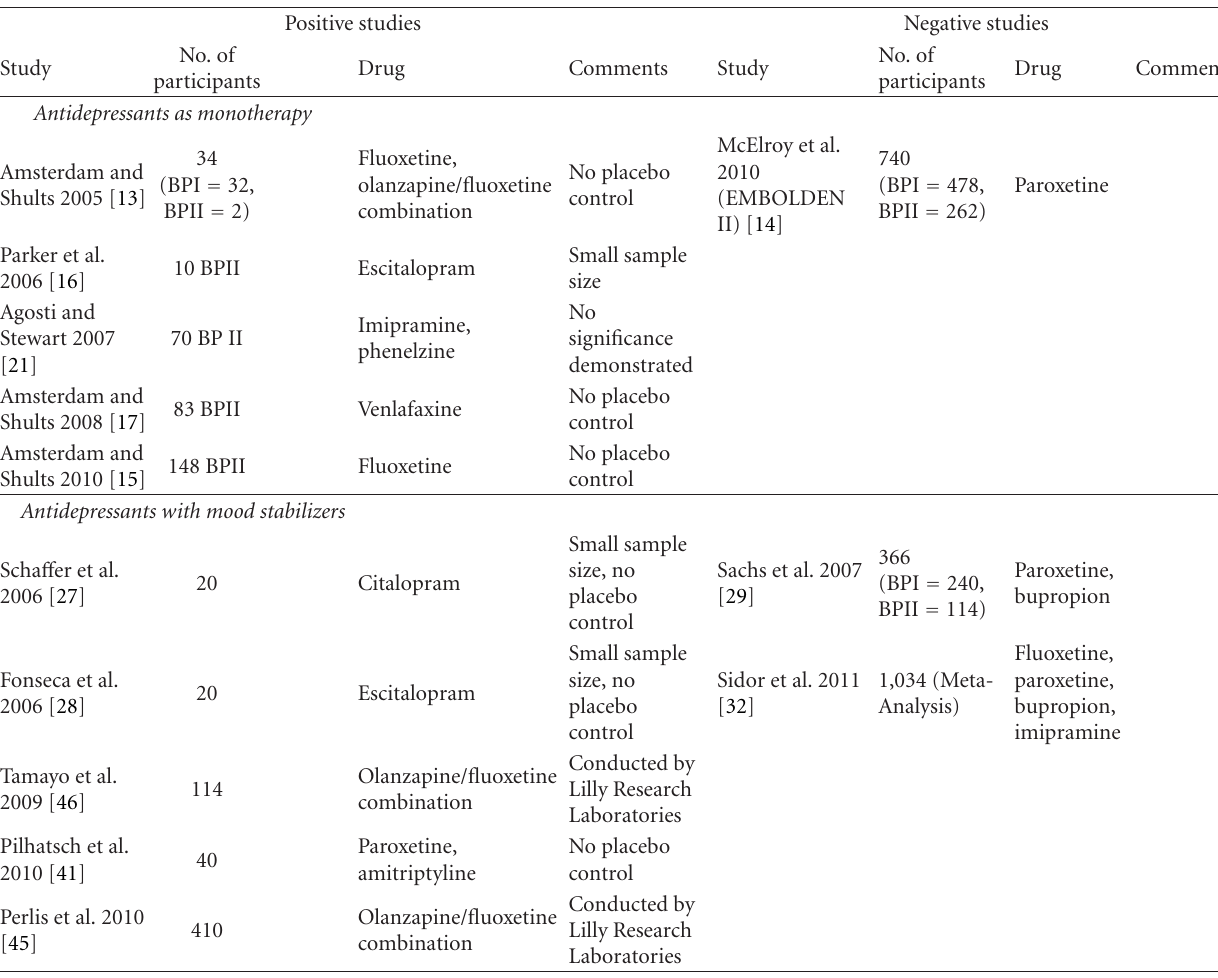
Table 1: Summary of recent studies examining the e ffi cacy of antidepressants in the treatment of acute bipolar